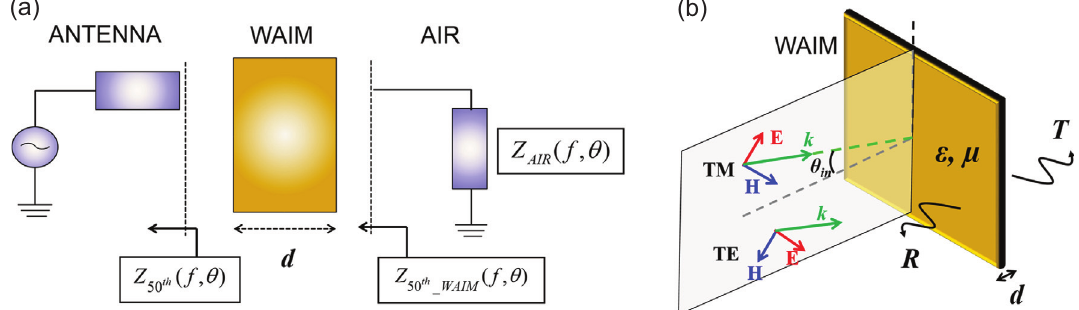
Figure 6. (a) Equivalent circuit block diagram of equivalent transmission line problem comprising the antenna and finite WAIM slab system embedded in air. (b) TM and TE oblique incidence of a plane wave on an infinite dielectric slab with finite thickness d and constitutive parameters e and l